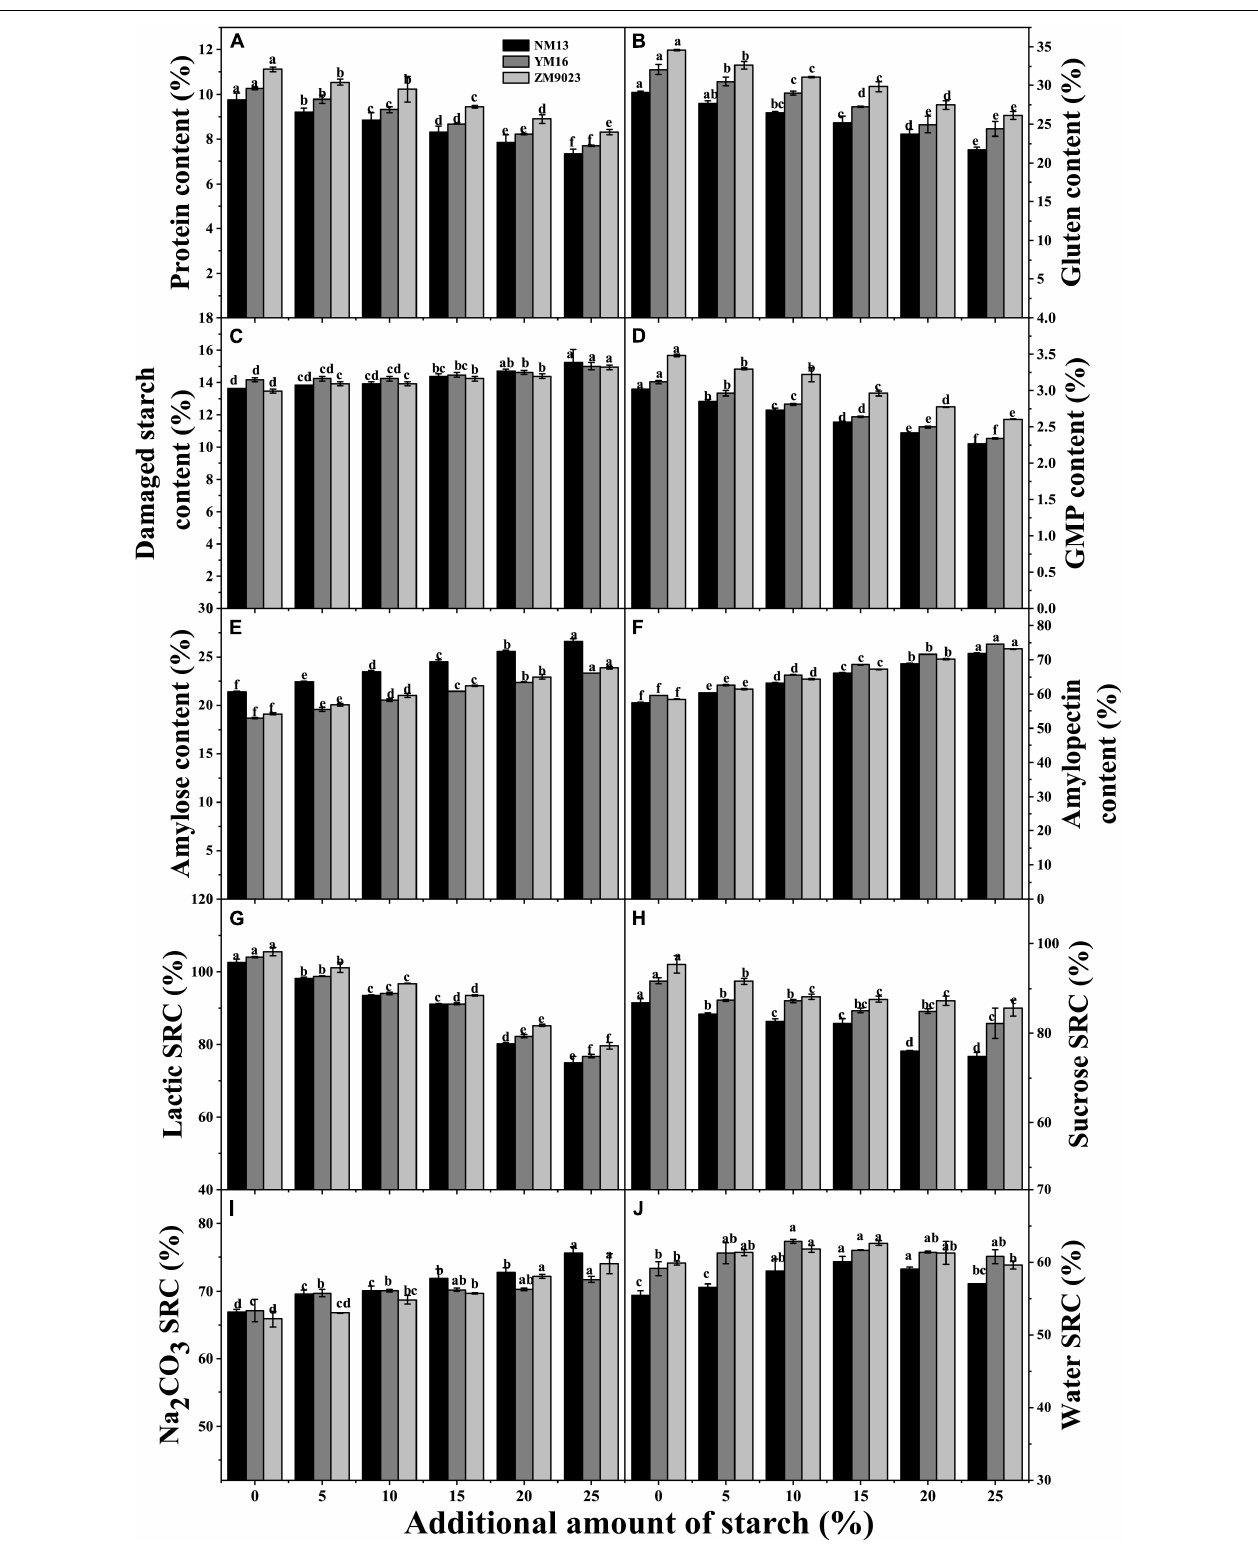
FIGURE 1 | Effects of the addition amount of starch on contents of protein (A) , gluten (B) , GMP (D) , damaged starch (C) , starch components ( E , amylose content; F amylopection content) and SRC in the recombined flour ( G , Latic SRC; H , Sucrose SRC; I , Na 2 CO 3 SRC; J , Water SRC). NM13, YM16, and ZM9023 indicate Ningmai 13, Yangmai 16, and Zhengmai 9023, respectively.